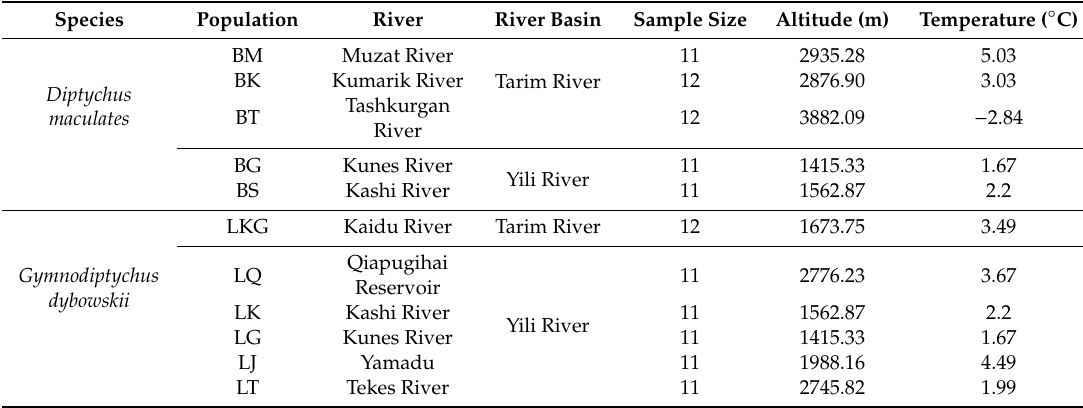
Table 1. Sampling information of two